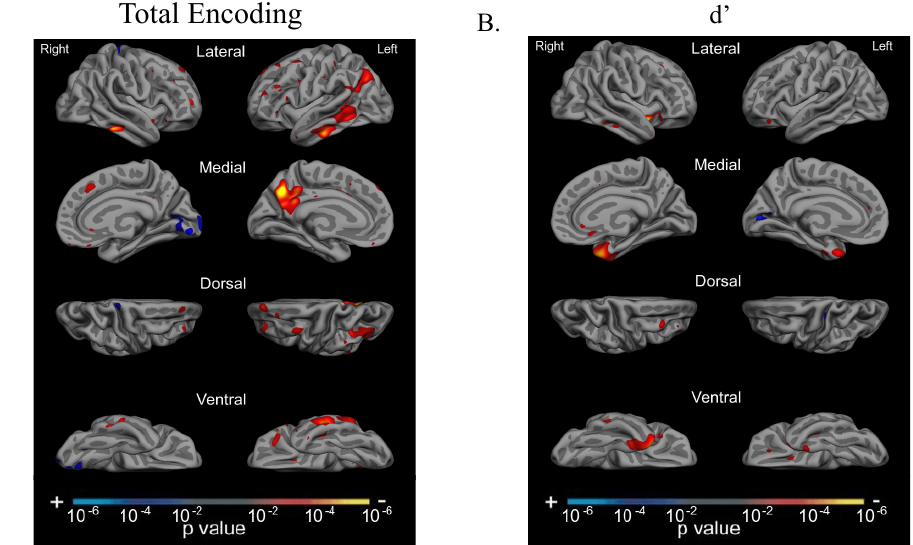
Figure 3. Total encoding and recognition discriminability (d’) are related to dissociable regions of atrophy. ( A ) Total learning (sum of Trials 1–4) was related to cortical atrophy in the left-hemisphere lateral middle and inferior temporal gyrus, as well as angular gyrus and posterior cingulate cor- tex/precuneus regions in the entire sample of AD participants at a threshold of p < 0.01. ( B ) Recogni- tion discriminability was related to cortical atrophy in the left-hemisphere anterior medial temporal lobe across AD participants at a threshold of p <